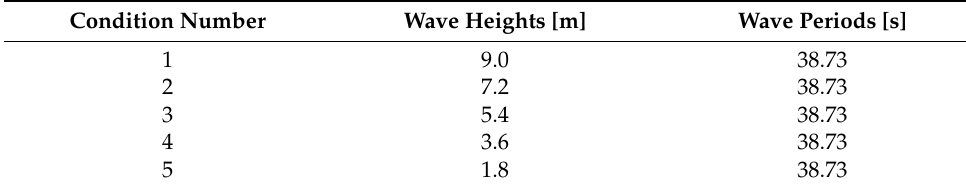
Table 7. The condition of numerical simulation.